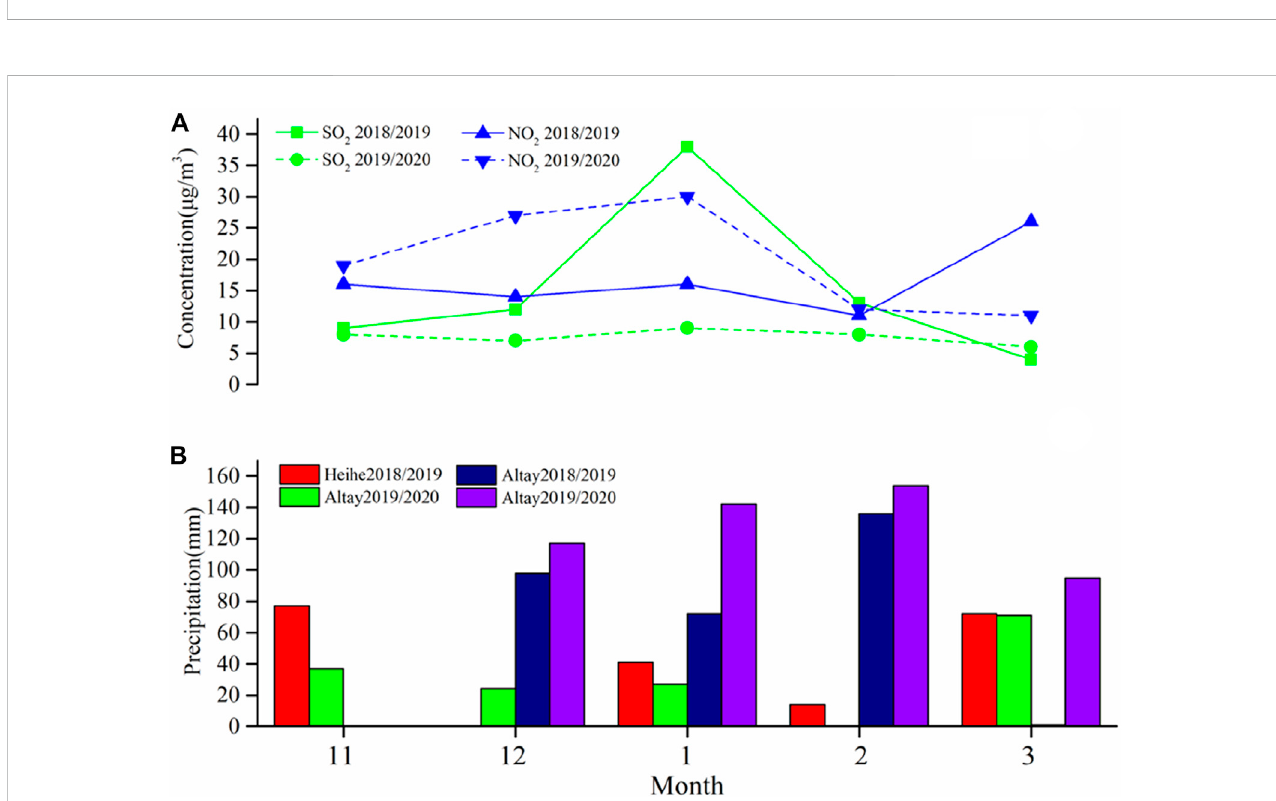
FIGURE 6 (A) is the change in concentration of SO 2 and NO 2 in the air during the sampling period in Altay region. The solid line is 2018/2019 and the dotted line is 2019/2020. (B) is the average value of monthly precipitation in the study area during the sampling period. The average value of monthly precipitation